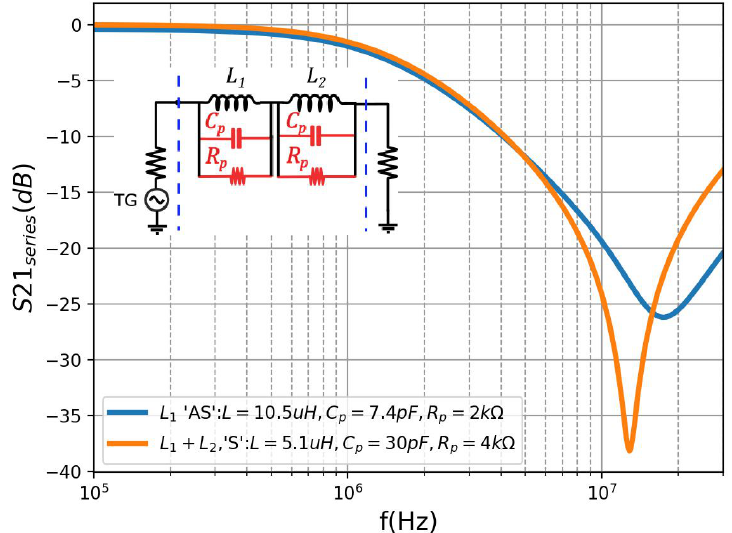
Figure A2. Transmission coefficient ( S 21 ) of the inductors L 1 and L 2 employed in ‘S’ and ‘AS’ configu- rations of the output LC filter of the